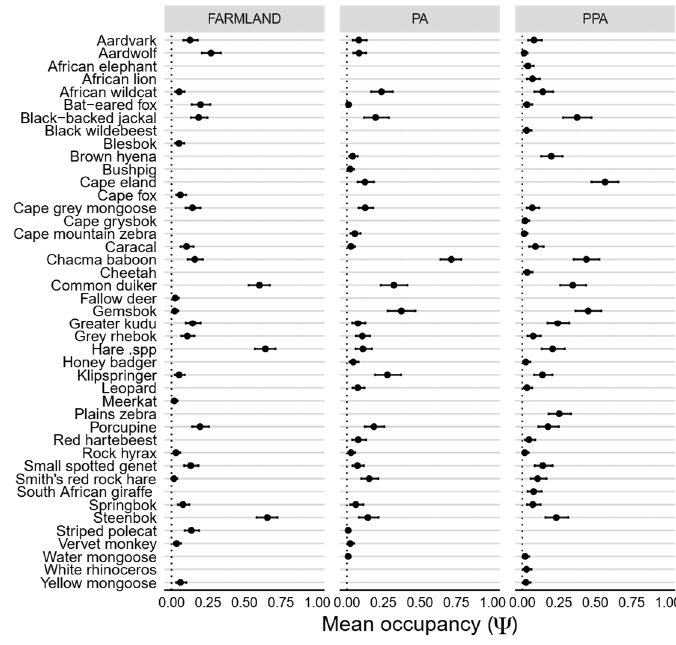
Figure A1. Caterpillar plots showing posterior means of occurrence ( Ψ ) probabilities per species, as estimated under a hierarchical multi-species occupancy model, in farmland, PA and PPA. Error bars represent 95% Bayesian credible intervals.